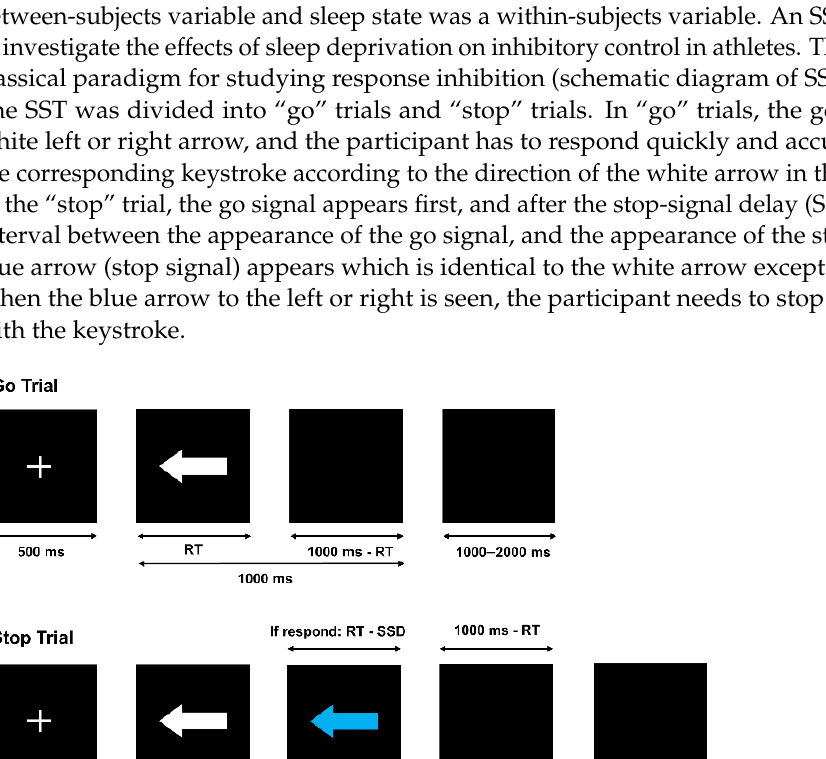
and required the participant to stop